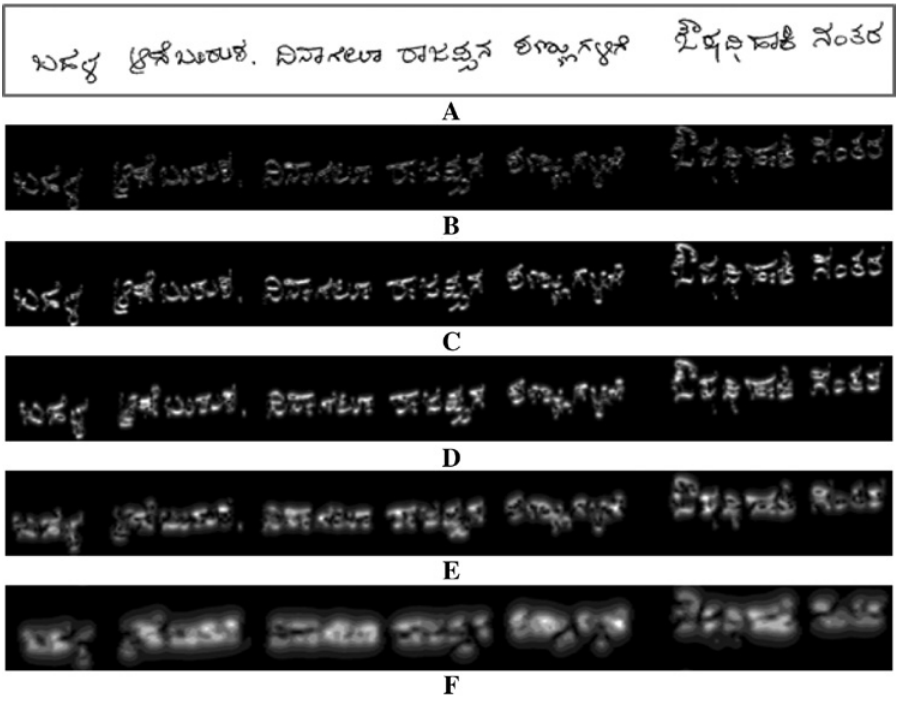
Figure 3: Output Images After Applying Gabor Wavelets on (A) a Sample Handwritten Kannada Text-Line Image for (B–F) Five Scales and Orientation = 45 ° .